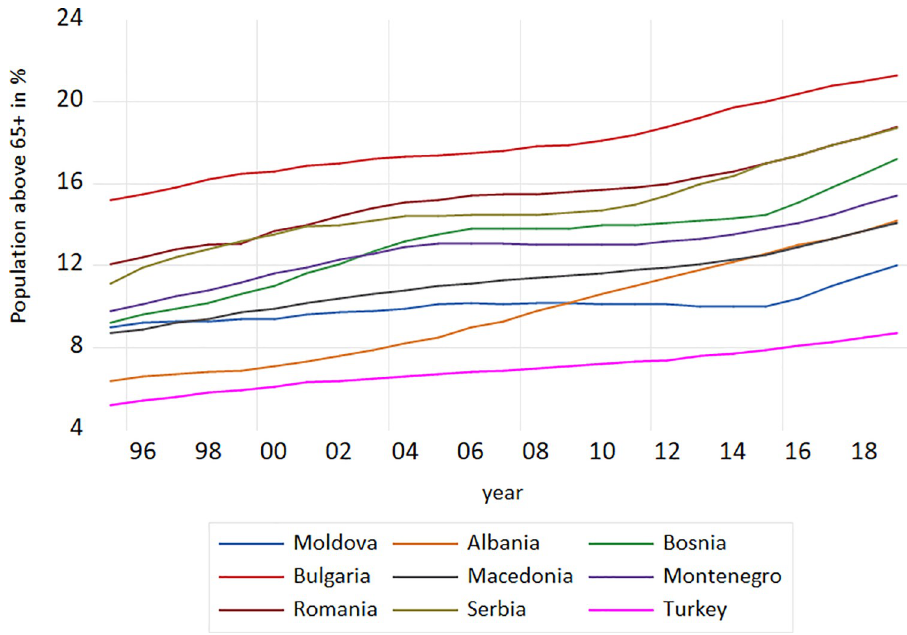
Fig 1. Population 65+ in the European middle income countries, 1995–2019. Source: Author’s design based on World Bank and UN data.